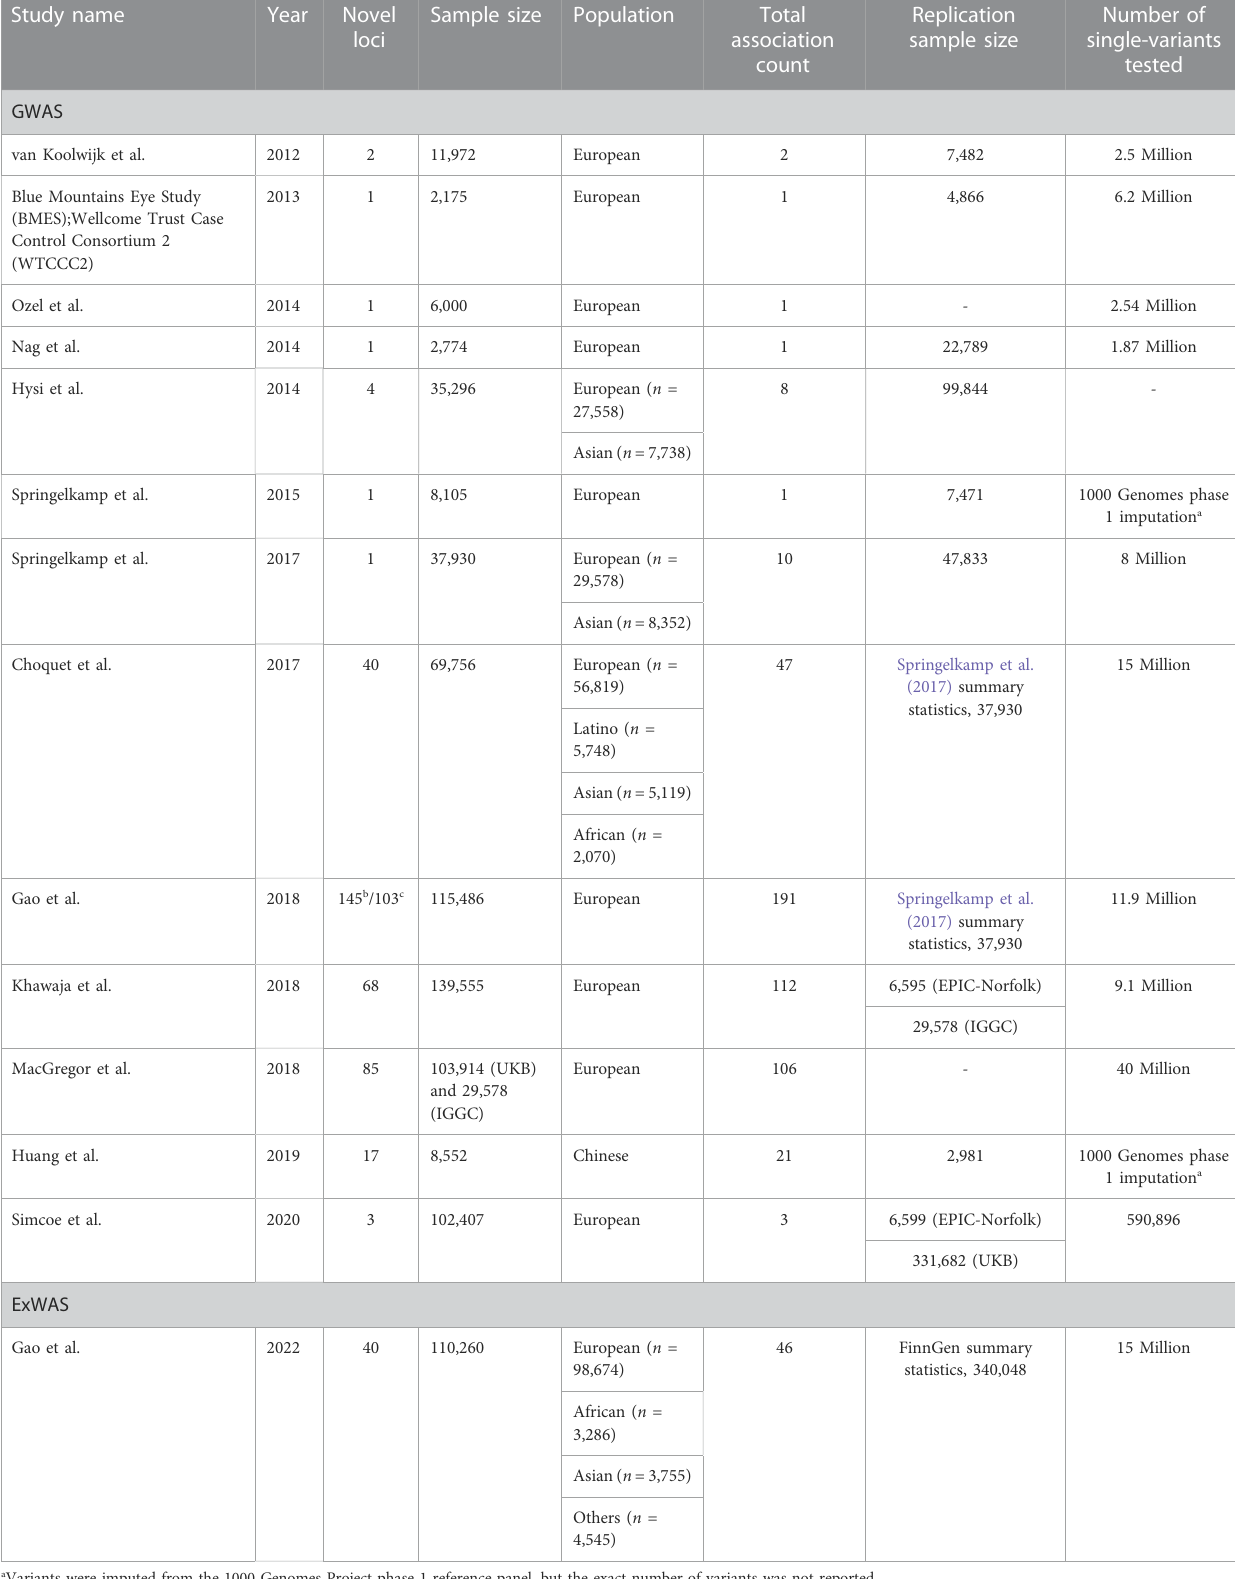
TABLE 1 Genome-wide and exome-wide association studies of intraocular pressure in the last 10